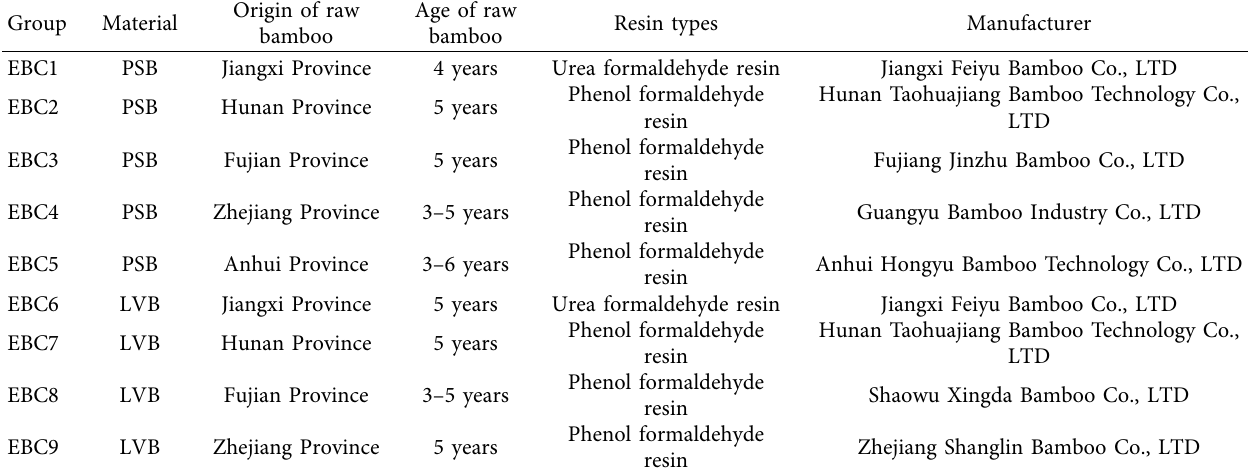
Table 1: The raw material information of engineered bamboo